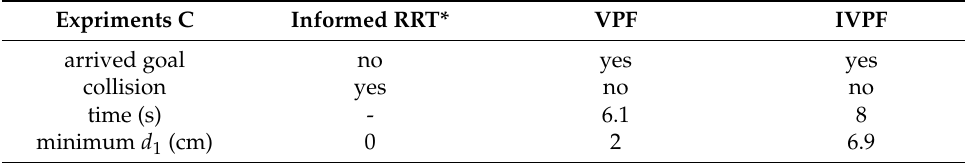
Figure 10. Experiments C: the distance between the robot arm and the target point and obstacle in the simulation experiments. ( a – c ) The results of the three algorithms. ( a ) informed RRT*; ( b ) VPF; ( c ) IVPF. Table 5. The result of static obstacles avoidance experiment